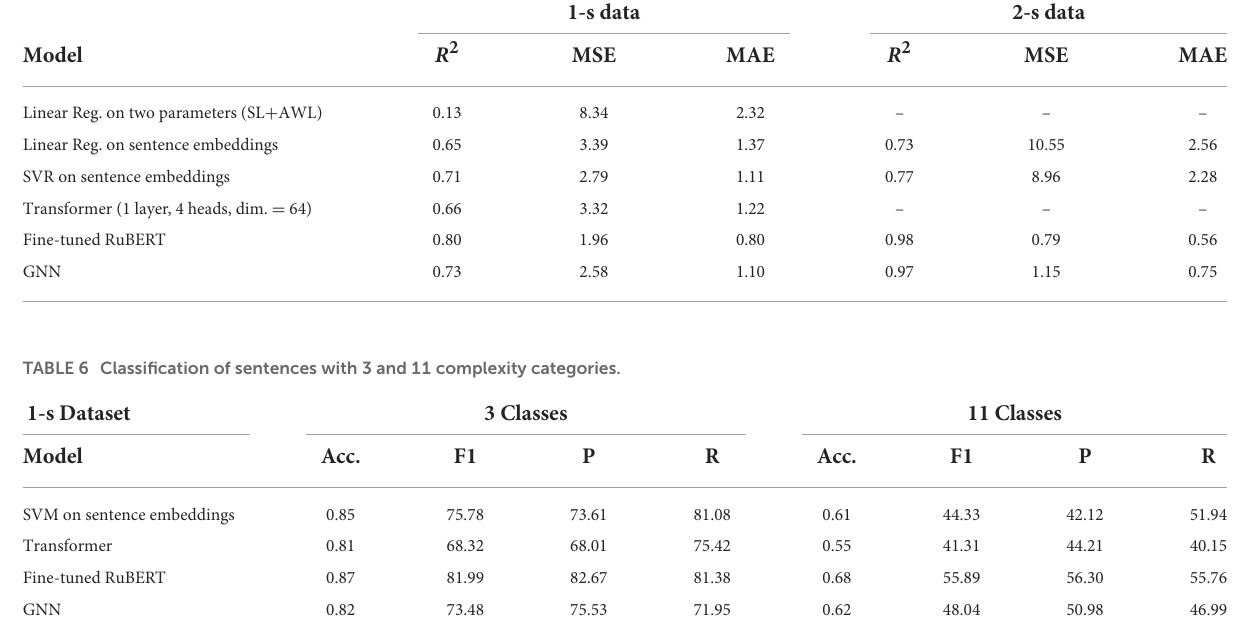
TABLE 5 Regression of single sentence complexity (1-s data) and pairs (2-s data).